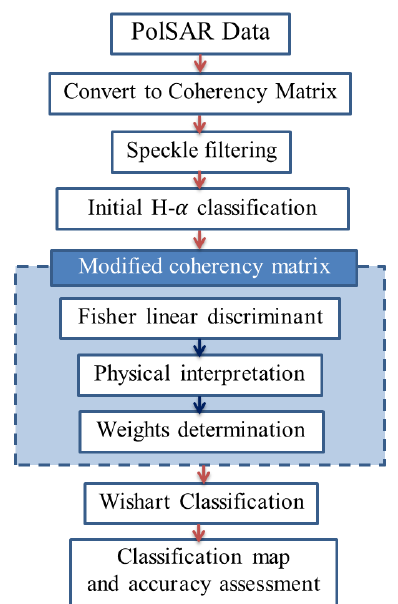
Figure 2. The flowchart of proposed method for wetland